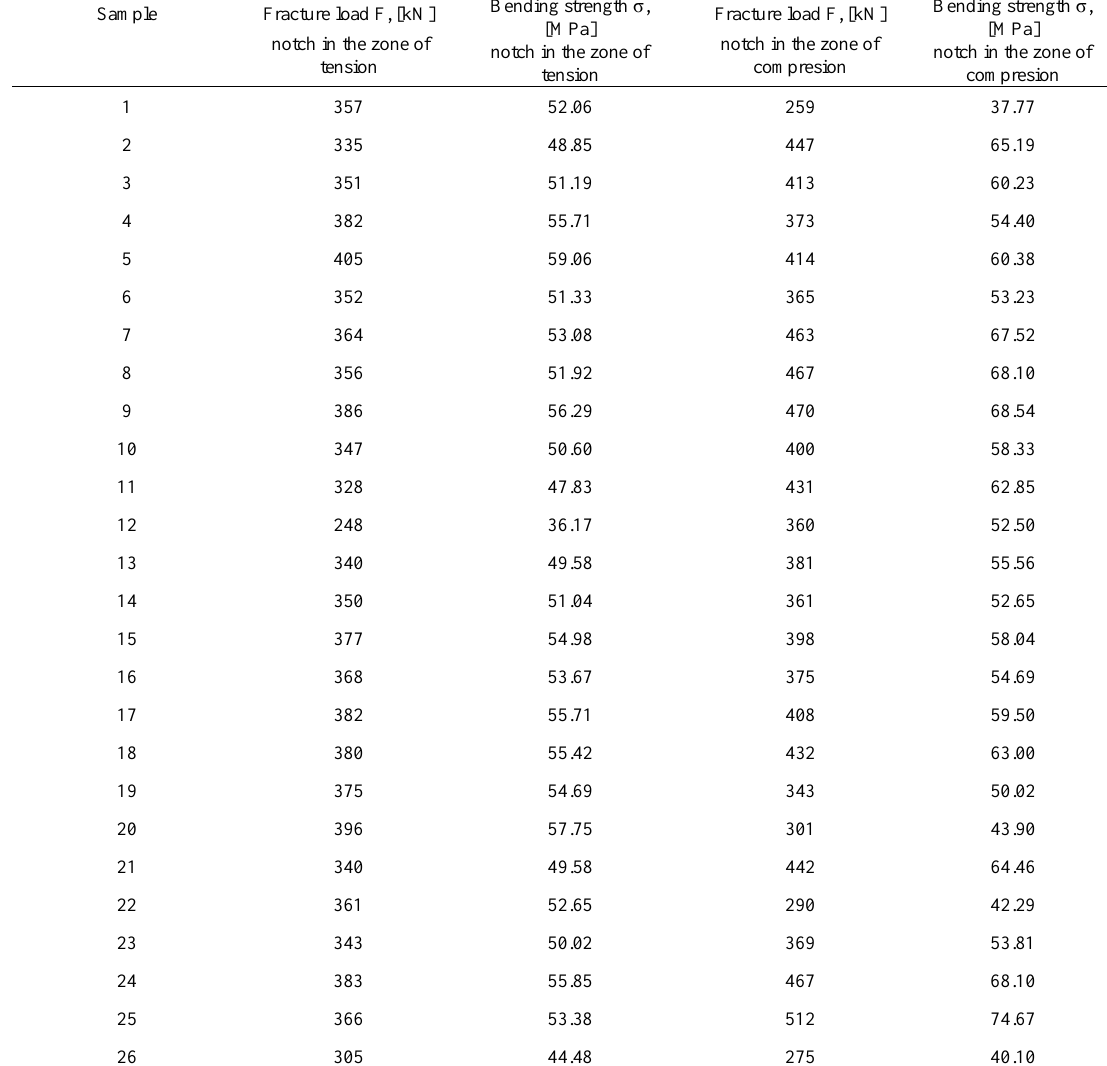
Table 1 The results of bending tests in horizontal position of flat